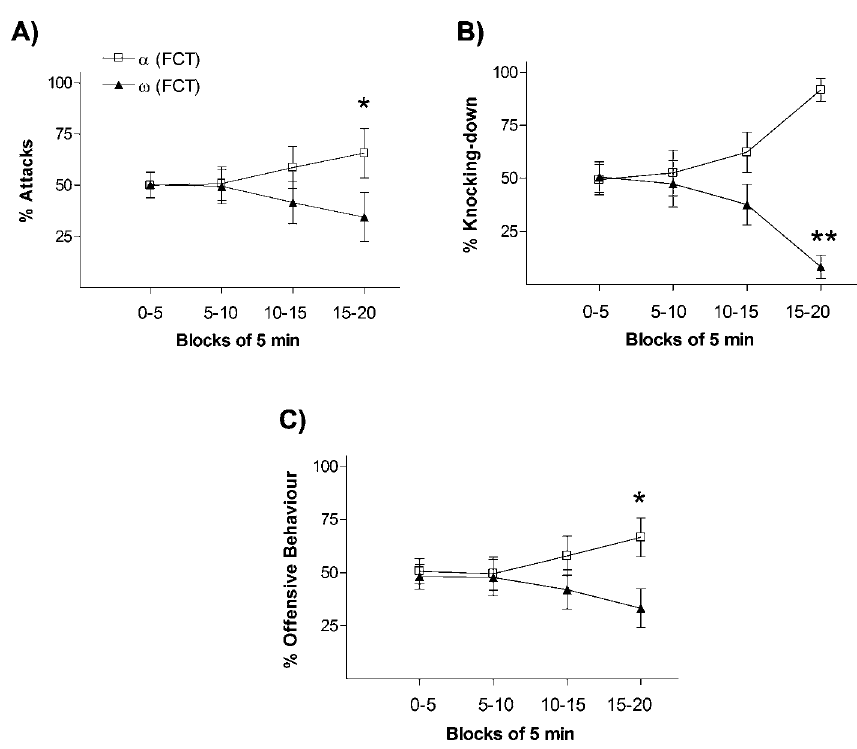
Figure 1. Behavior progression during the 20minutes of social interaction (pre-FCT) represented in blocks of interval of 5minutes. The graphs represent rates between opponents of frequency of (A) attacks, (B) knocking-down, and (C) offensive behavior. * p<0.05, ** p<0.01.